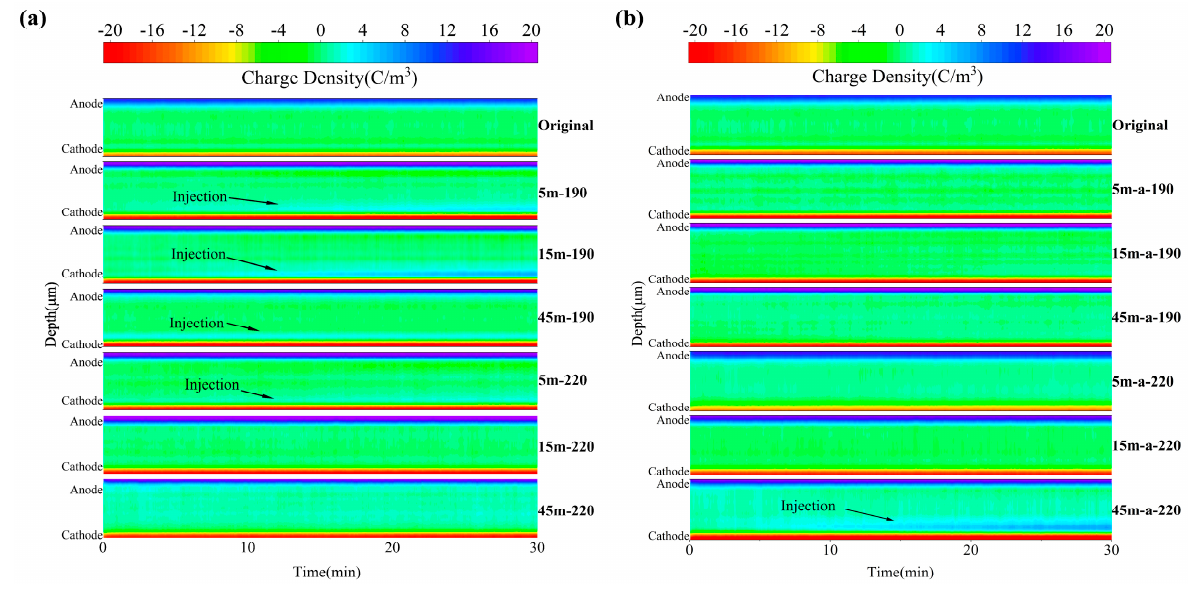
Figure 8. Space charge density in the polarization process of each sample. ( a ): The distribution of space charges of samples without antioxidant; ( b ): The distribution of space charges of samples with antioxidant. (Original is the space charge distribution of the original pp used as a contrast.) As the polarization time increases for unsheared PP, the figures indicate that there is no obvious space charge injection phenomenon within the sample. With the increase of